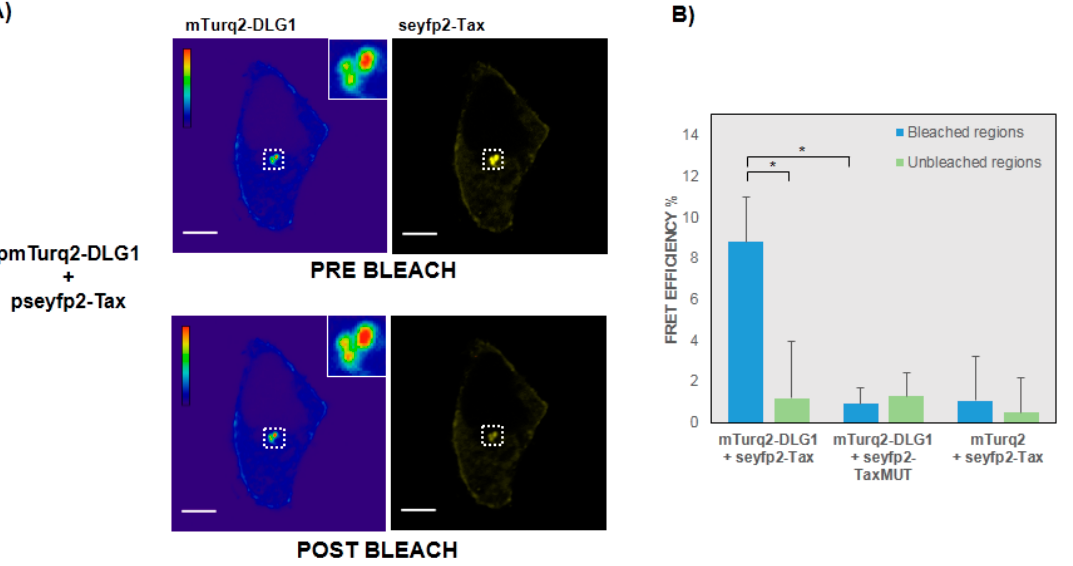
Figure 3. Detection of the DLG1-Tax interaction by fluorescence resonance energy transfer (FRET) microscopy. ( A ) Acceptor photobleaching FRET experiments. HEK293 epithelial cells transiently